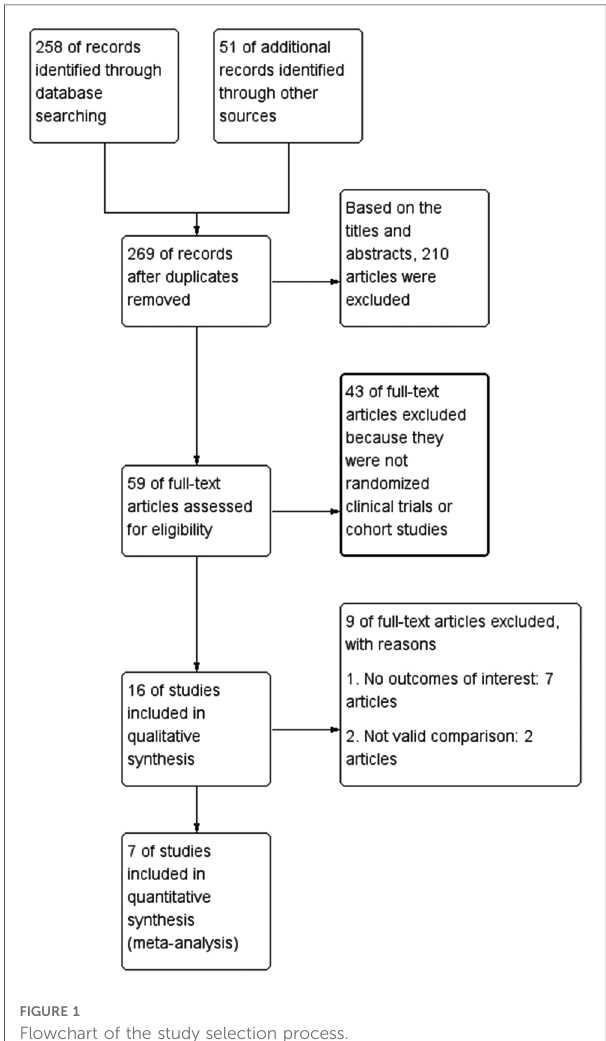
FIGURE 1 Flowchart of the study selection